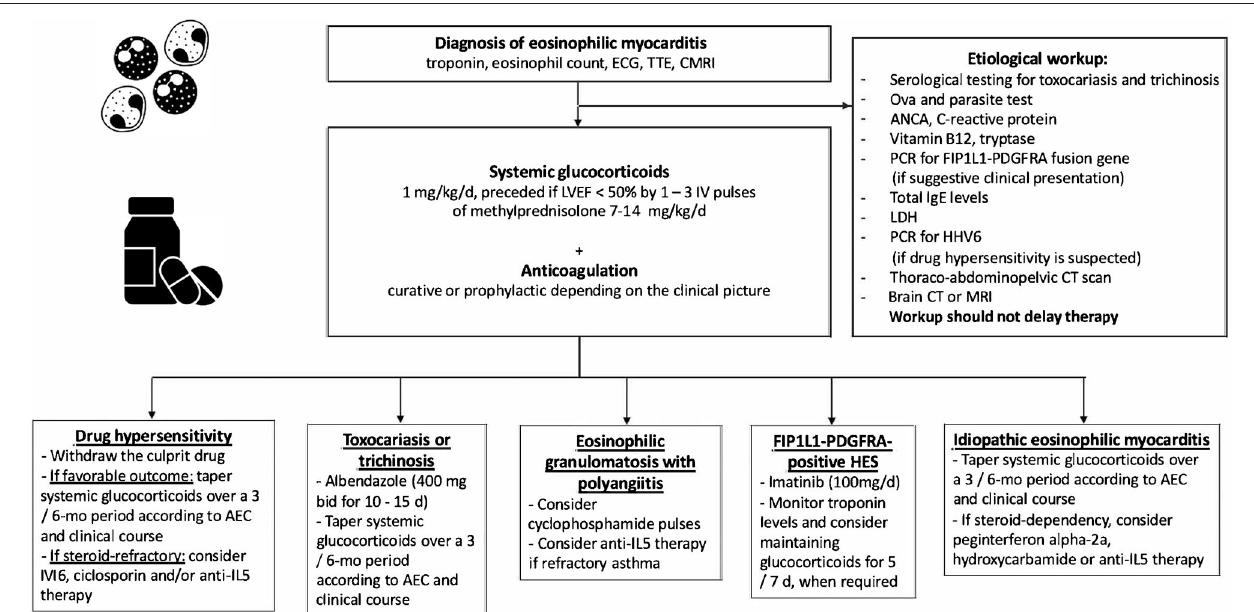
FIGURE 3 | Etiological workup and immunosuppressive treatment strategies used for eosinophilic myocarditis. TTE, transthoracic echocardiography; CMRI, cardiac magnetic resonance; LVEF, left ventricular ejection fraction; ANCA, antineutrophil cytoplasmic antibodies; PCR, polymerase chain reaction; LDH, lactate dehydrogenase; HHV6, human herpes virus 6; CT, computed tomography; d, day; mo, month; AEC, absolute eosinophil count; HES, hypereosinophilic